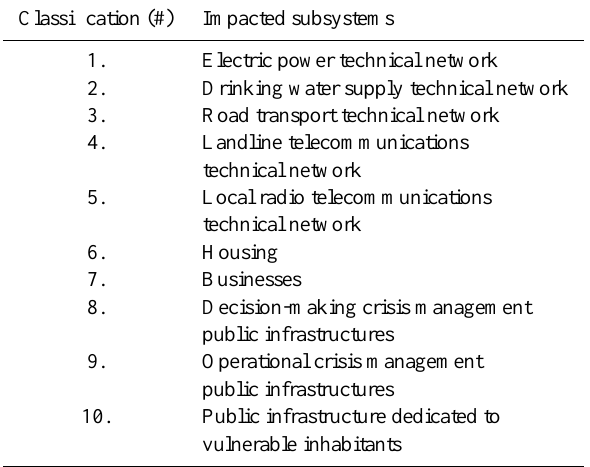
Table 4. Subsystems impacted by flooding event in Nîmes